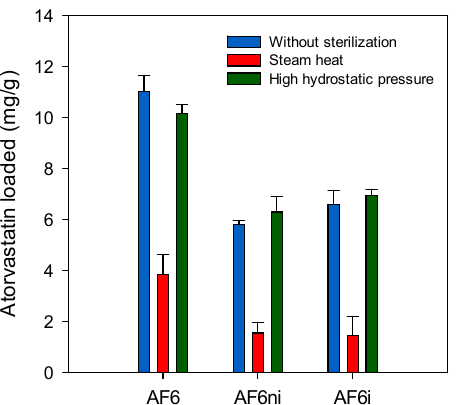
Figure 10. Atorvastatin loaded by AF6, AF6ni, and AF6i hydrogels when they were sterilized in drug solution by means of steam heat or high hydrostatic pressure, compared to nonsterilized hy- drogels.